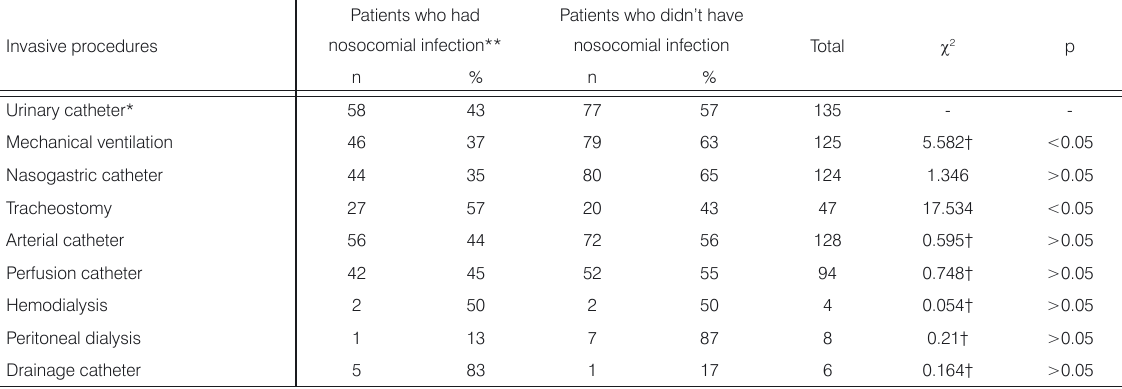
Table 2. The invasive procedures and their relation with the nosocomial infections. Invasive